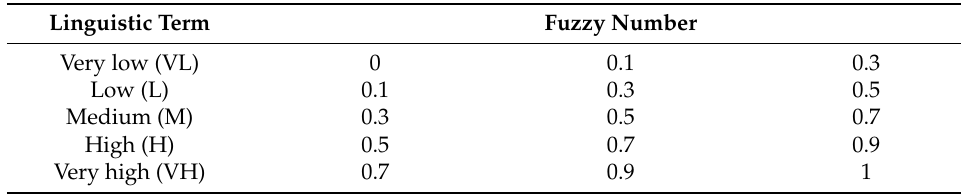
Table 1. Linguistic variables presented by triangular fuzzy